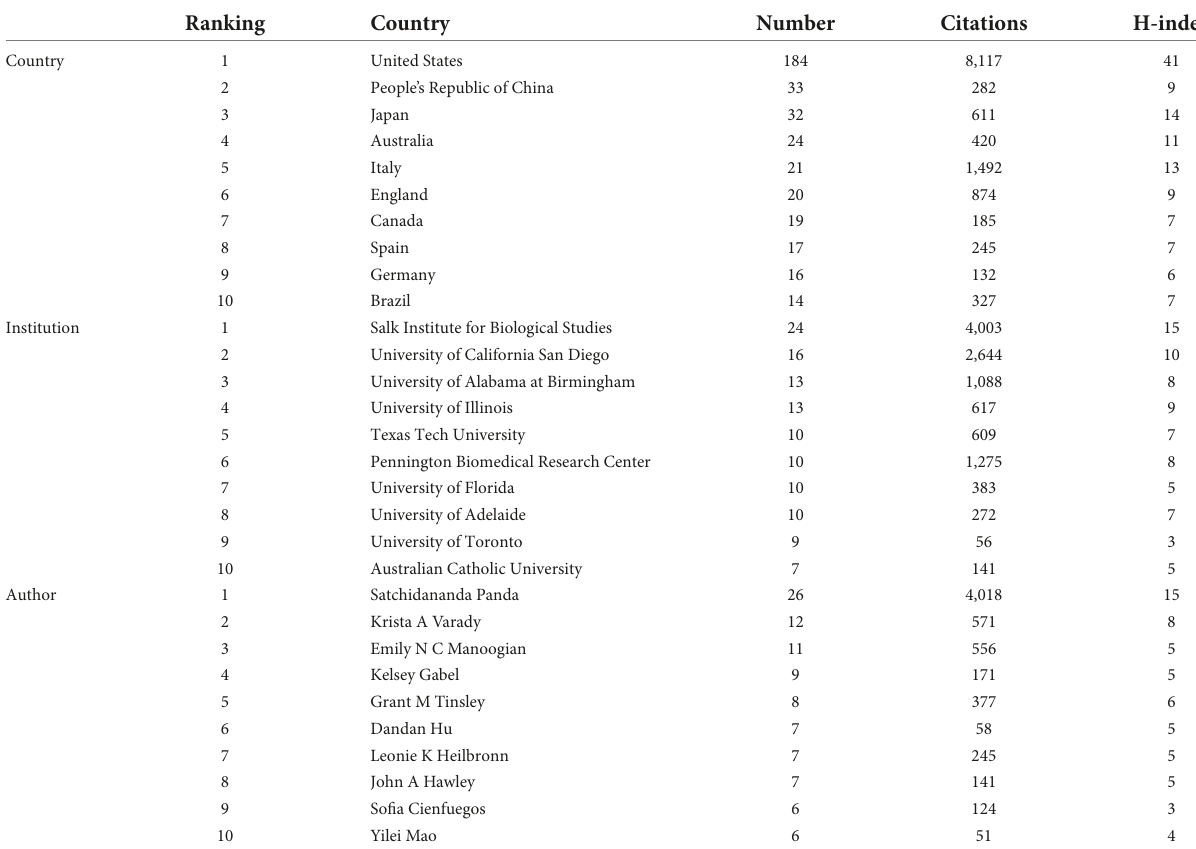
TABLE 1 Ranking of the top 10 authors, institutions, and countries.